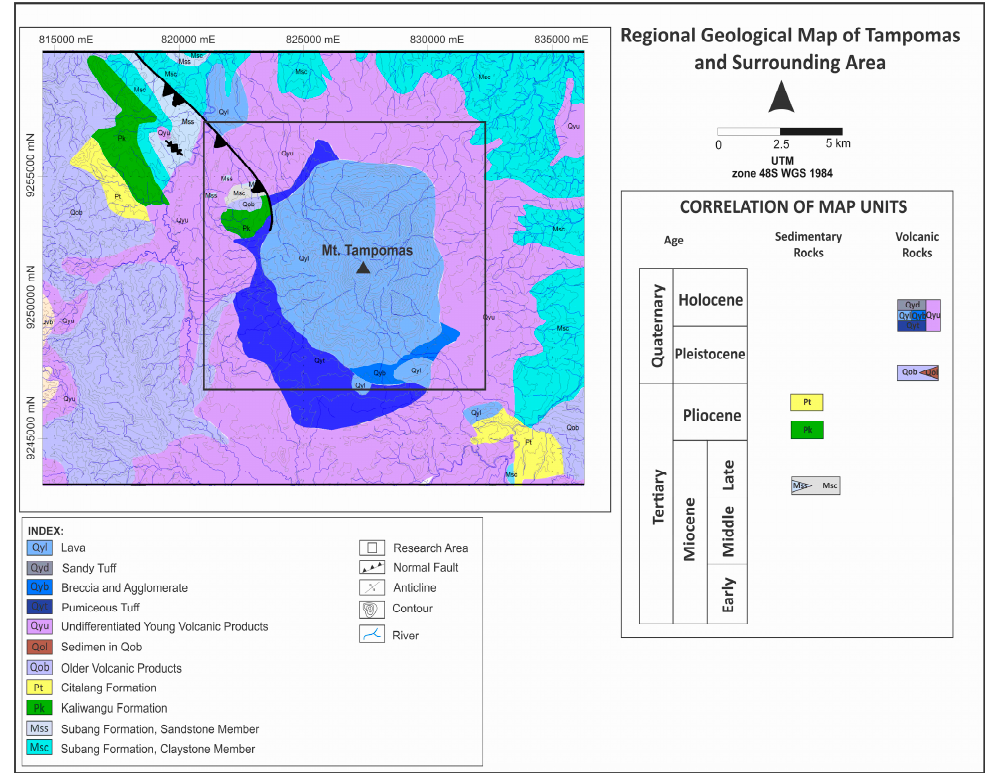
Figure 2. The regional geology of the recent Tampomas Volcano area and surroundings. It is comprised of Tertiary sedimentary rock in the outer circle zone and covered by Quaternary volcanic product in the inner circle zone (modification from